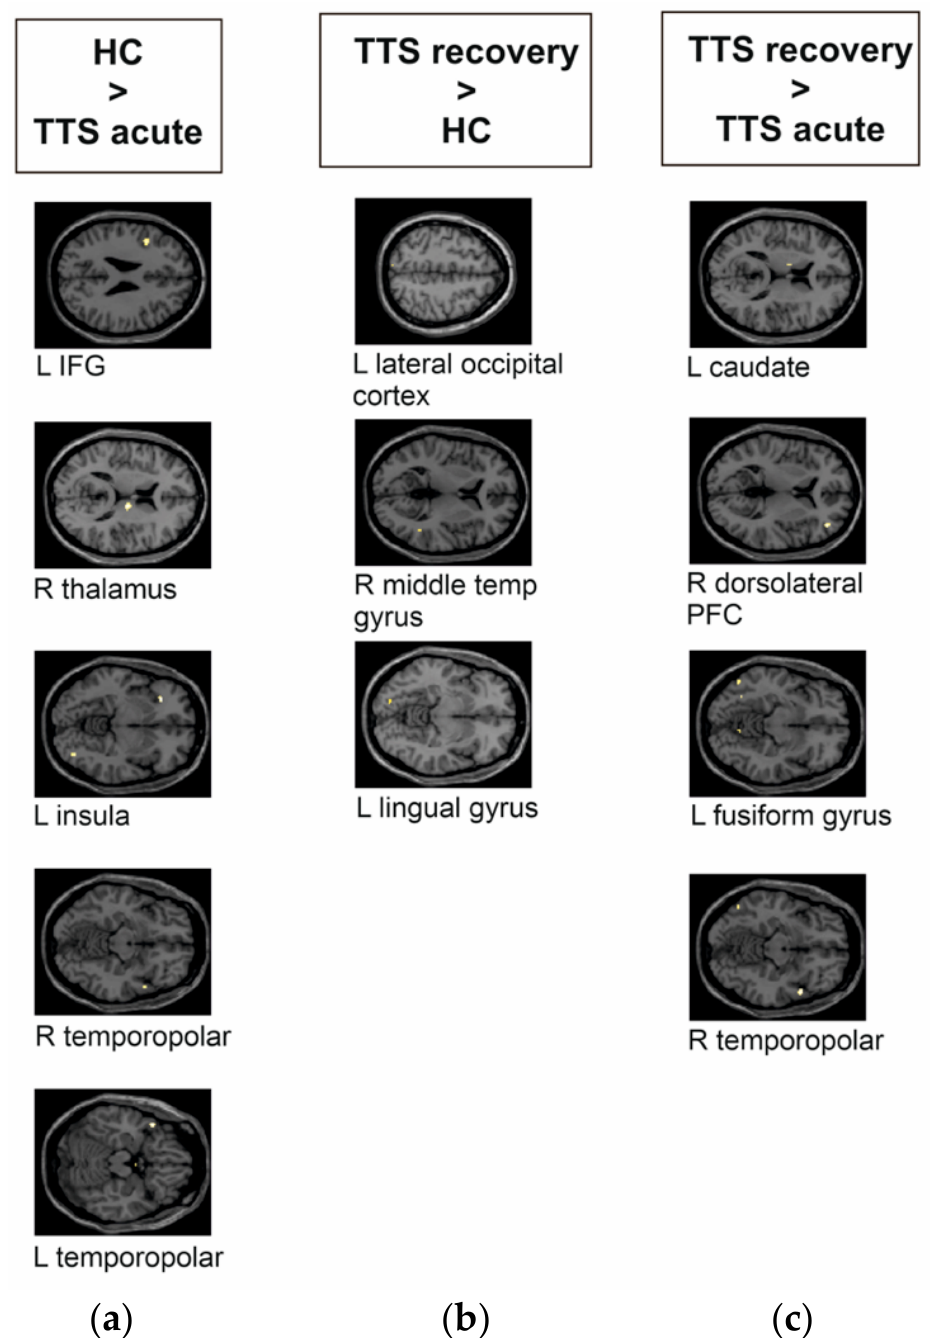
Figure 2. Group differences of takotsubo syndrome patients (TTS) and healthy controls (HC) during the emotional task-based fMRI paradigm during the decoding of aversive versus positive pictures from the IAPS. The brain images are presented in MNI space. ( a ) TTS acute phase compared to HC had significantly lower mean activity in the left inferior frontal gyrus (IFG), right thalamus, left insula, and in the right and left temporopolar areas. ( b ) TTS recovery phase compared to HC had significantly higher activity within the left lateral occipital cortex, right middle temporal gyrus, and left lingual gyrus. ( c ) TTS acute phase compared to TTS recovery phase had significantly lower responses in the left caudate, right dorsolateral prefrontal cortex (PFC), left fusiform gyrus, and right temporopolar